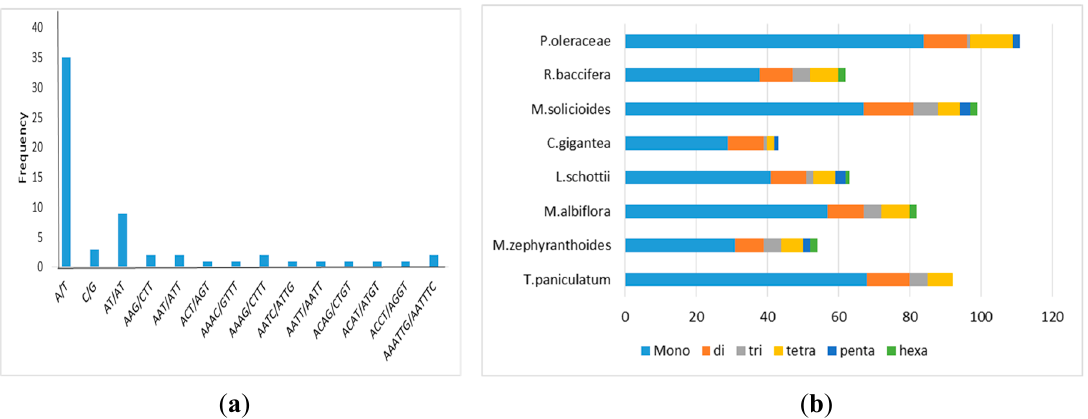
Figure 6. Simple sequence repeats (SSRs) type, distribution, and presence in suborder Portulacineae ; ( a ) Number of detected SSR motifs in different repeat types in R.baccifera chloroplast genome. ( b ) Number of identified repeat sequences in eight chloroplast genomes.